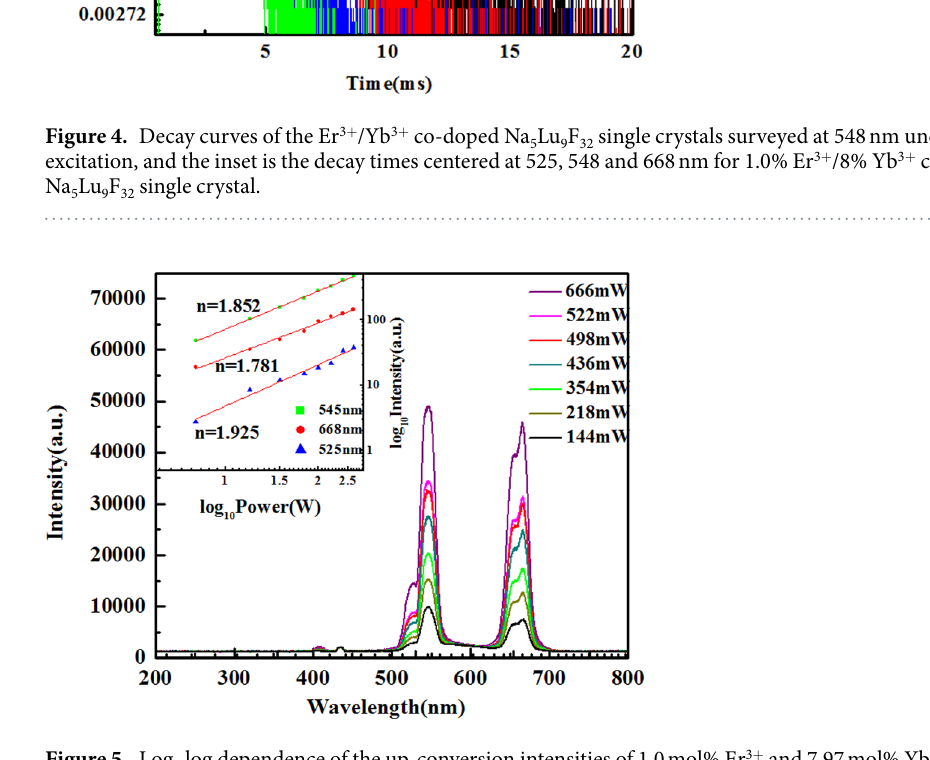
Figure 5. Log–log dependence of the up-conversion intensities of 1.0 mol% Er 3 + and 7.97 mol% Yb 3 + co-doped Na 5 Lu 9 F 32 single crystal at 525,548, 668 nm emissions as a function of the excitation power at 980